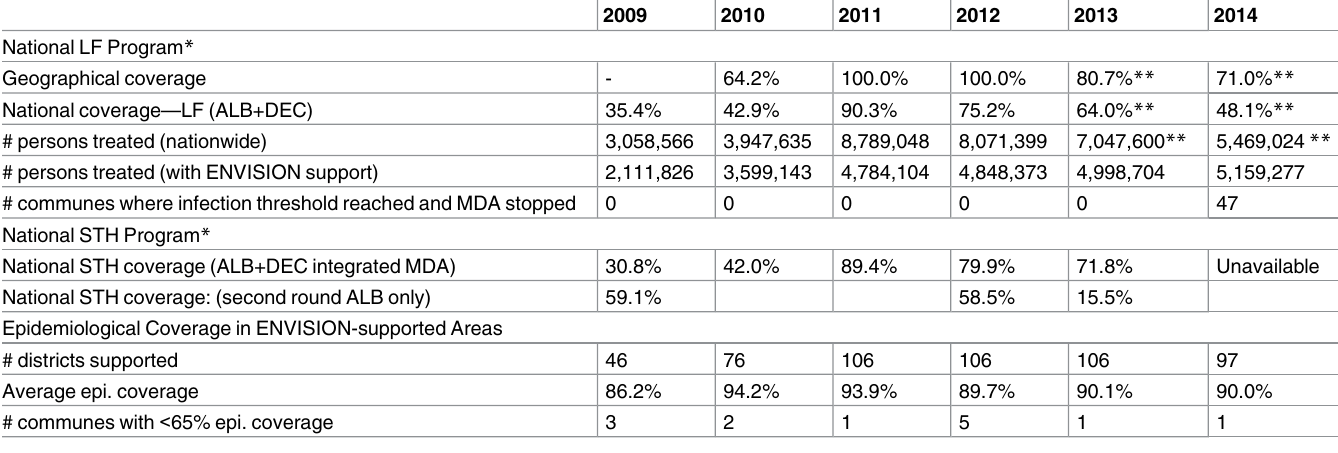
Table 1. Treatment coverage in Haiti, 2009–2014.